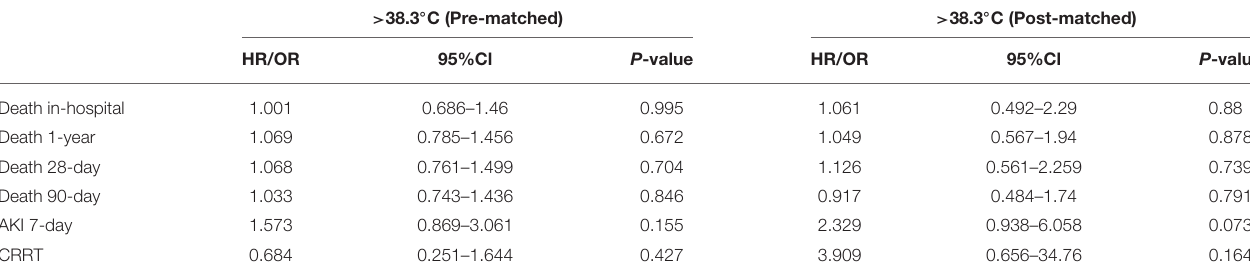
TABLE 5 | Multivariable cox regression and logistic regression analysis for